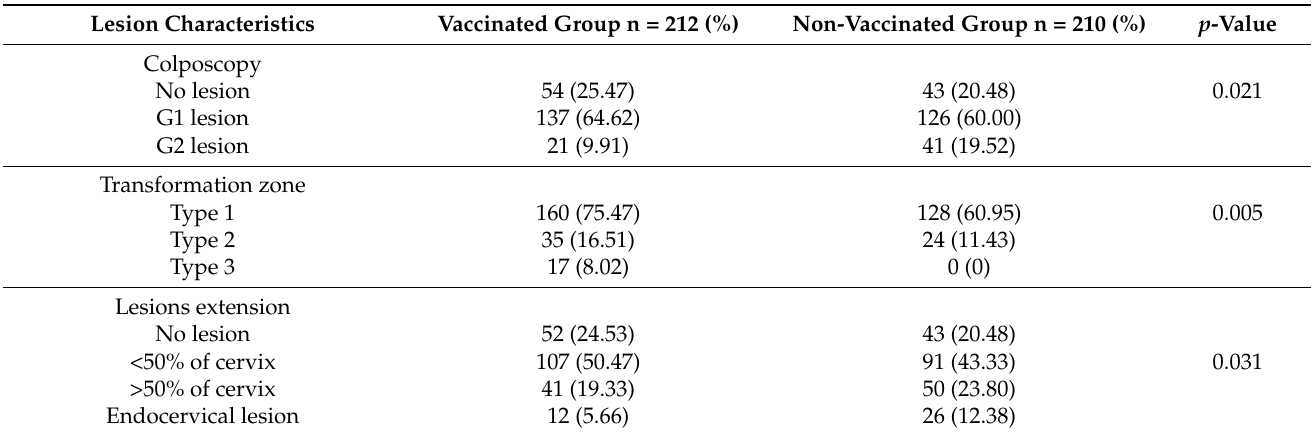
Table 2. Virological and colposcopic features at